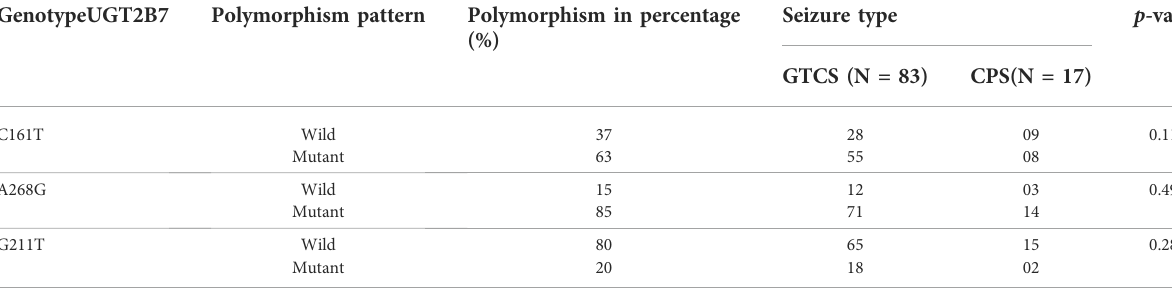
TABLE 3 Association of UGT2B7 gene polymorphisms with Seizure type (N =